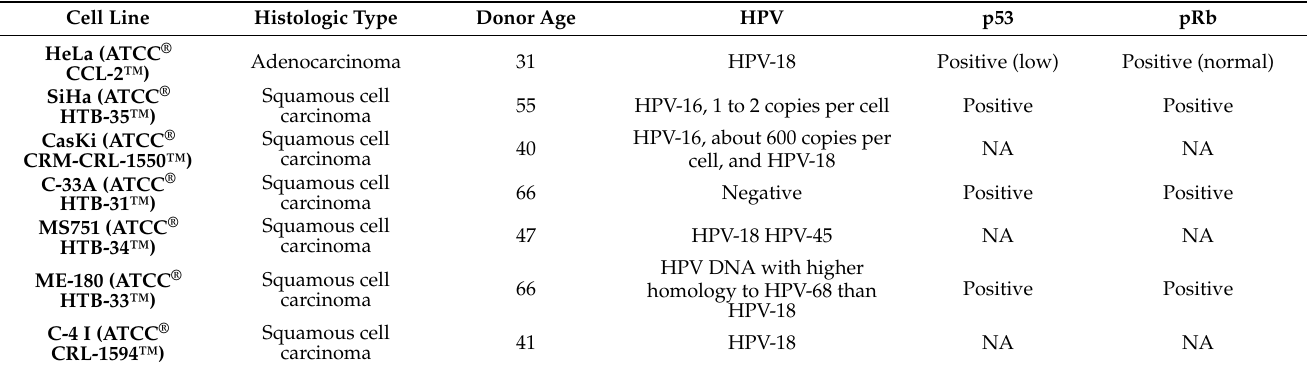
Table 1. Main human immortalized cervical cancer cell lines available for in vitro studies from uterine cervix tissues. Cell